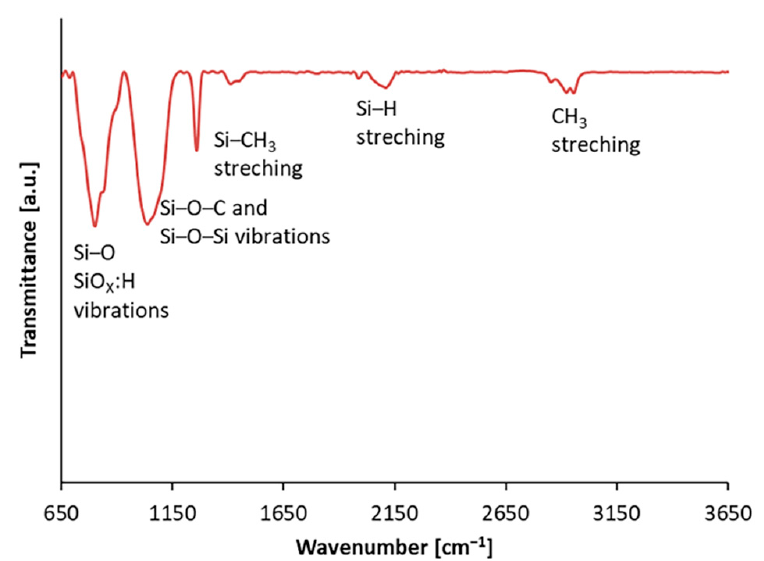
Figure 1. FTIR spectrum obtained for the 100 nm of organic coating deposited on silicon at 100 W, Ar/HMDSO ratio 3:1 and 1 Pa.